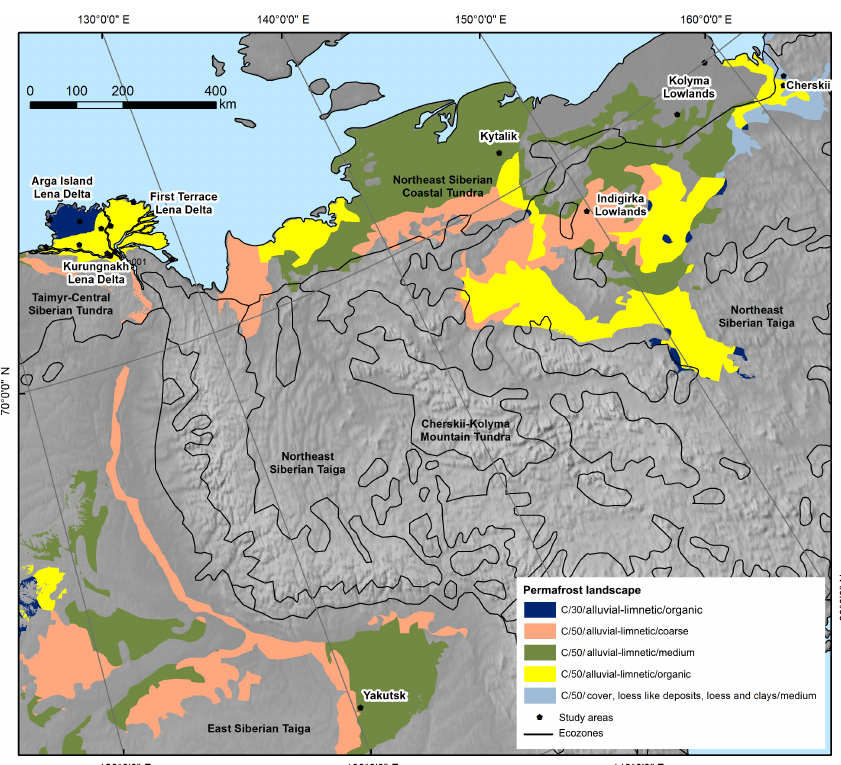
Figure D4. Study areas and associated permafrost landscapes in west Russia. Legend lists type of permafrost extent (C: continuous; D: dis- continuous; S: sporadic), ground ice content (vol%), surficial geology, and lithology. Shadowed labels name study areas with waterbody maps. Black lines and labels denote